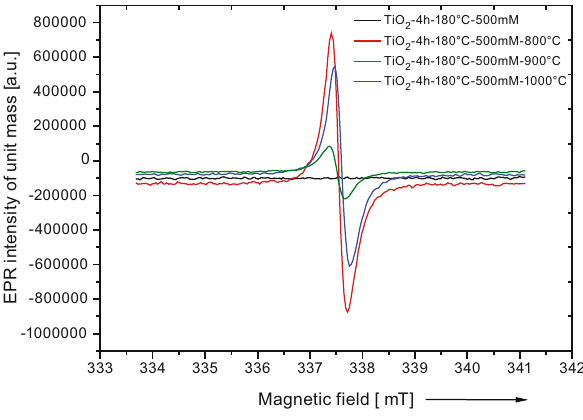
Figure 3: EPR spectra at RT of the